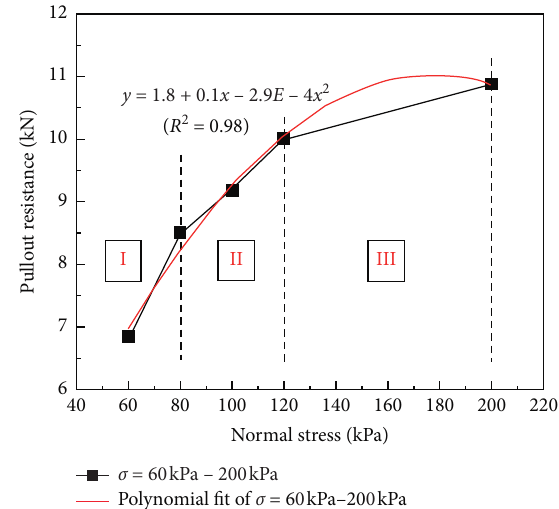
Figure 8: Global polynomial fitting of normal loads versus pullout resistance under σ � 60 kPa–200kPa. Figure 7: Pullout resistance-displacement under different normal